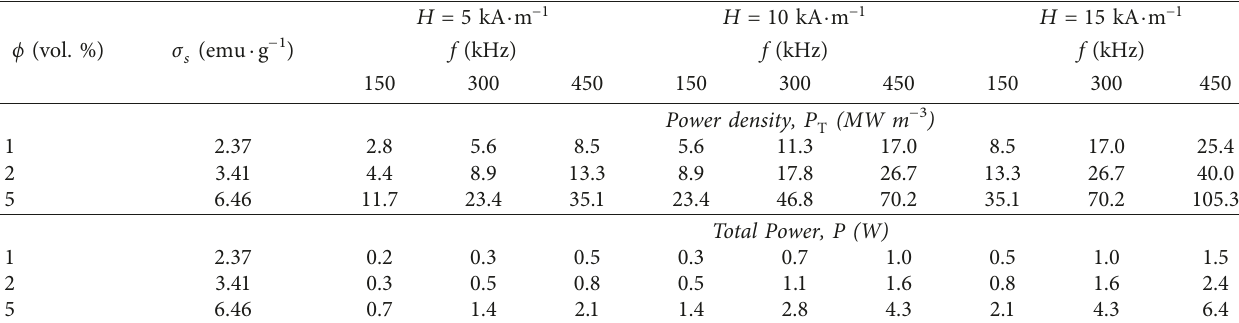
Table 3: Power density, P (W m predictions in Table 2.